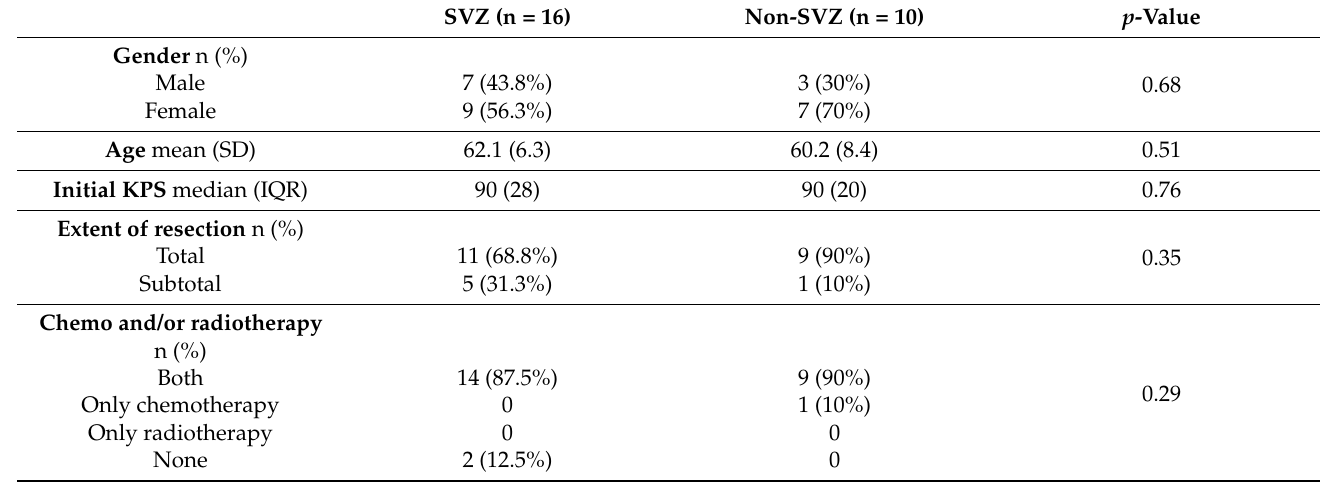
Table 1. Baseline Table 1. Baseline characteristics.